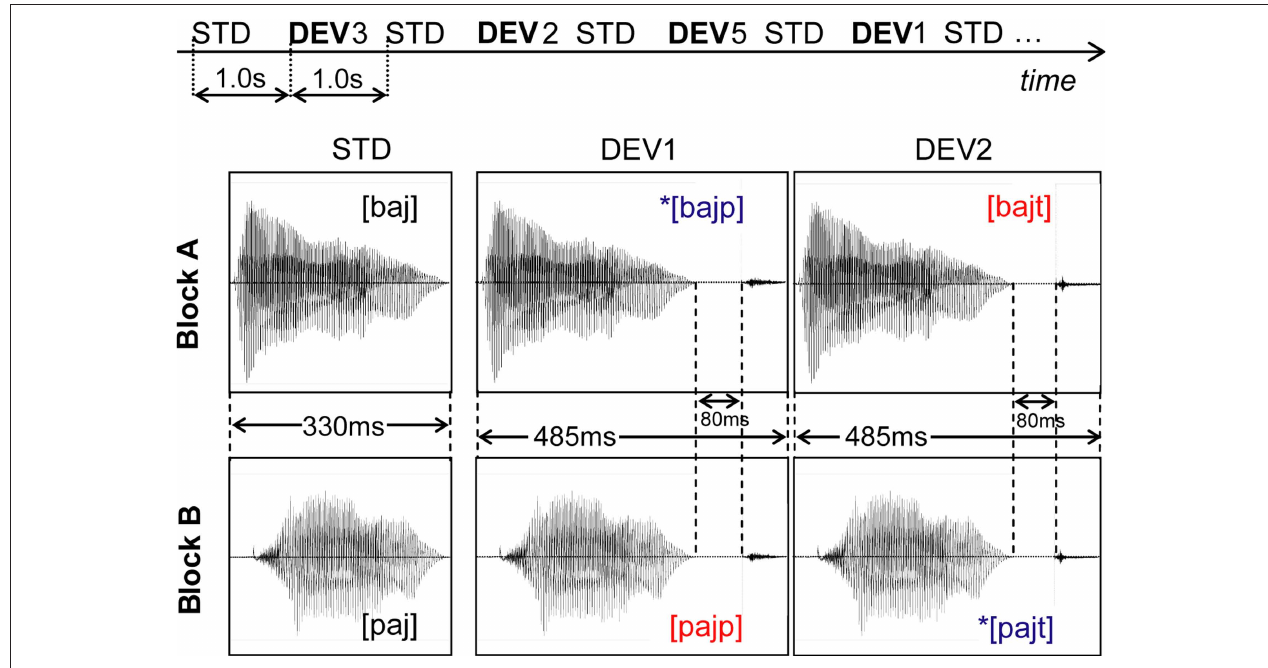
respective durations and phonetic representation. The additional deviant stimuli used (waveforms not shown) were: DEV3 = STD + 80 ms closure time + [k]; DEV4 = STD + 30 ms closure time + [g]; DEV5 a = STD + 230 ms closure time + [k], DEV5 b = STD + 180 ms closure time + [g], DEV5 c = STD. See text for